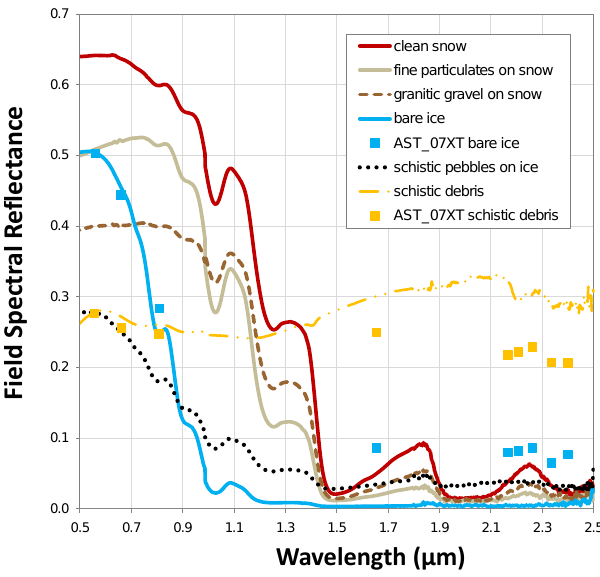
Fig. 3. Khumbu glacier snow, ice and debris field collected surface reflectance. Note the reduction in VNIR reflectance with increasing dust and debris compared to clean snow and bare ice signatures, and SWIR dominant schistic supraglacial debris signature. Satellite reflectance (ASTER AST 07XT) is compared with field reflectance for bare ice and schistic debris